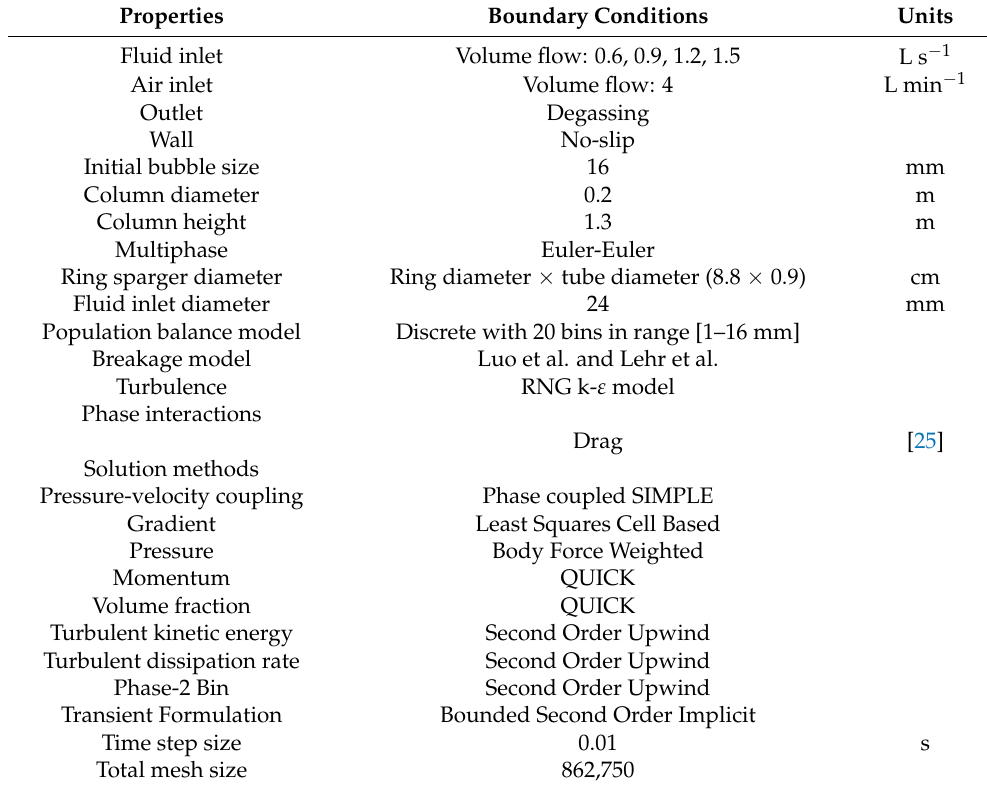
Figure 2. Mesh independence study with 3 different mesh densities. The turbulent dissipation rate on a vertical line in the center of the column is compared. ( a ): Ansys Fluent simulation ( b ): M-Star simulation. Table 1. Geometry, simulation set-up, boundary conditions and solver setting of bubble column simulation in Ansys